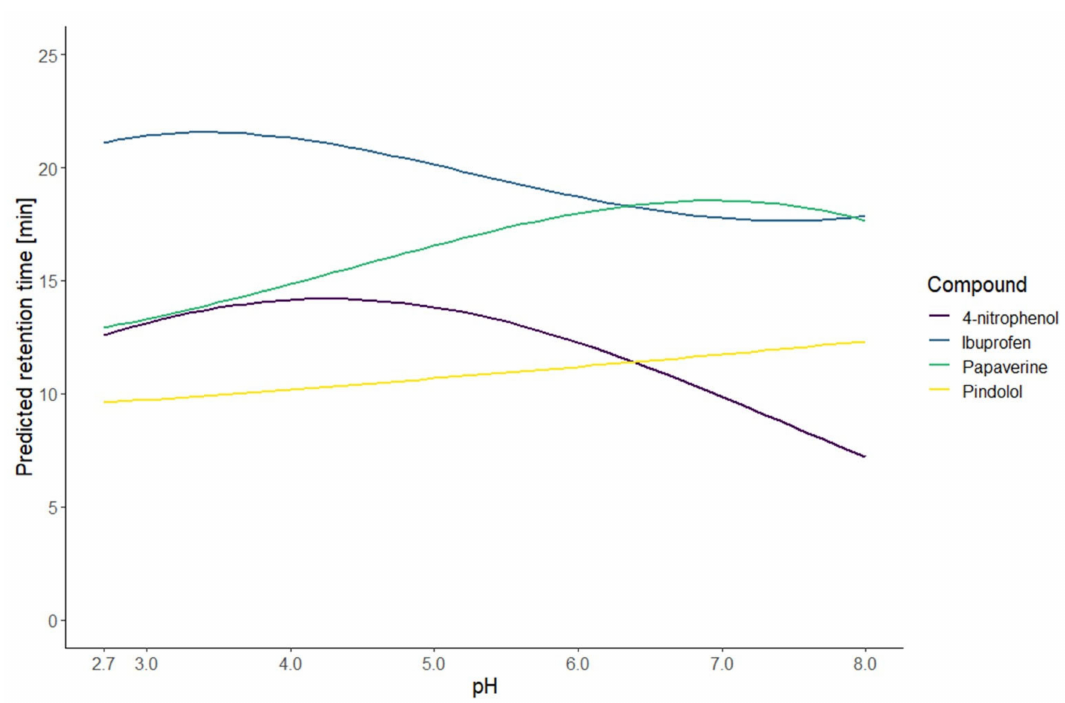
Figure 1. Curves of predicted retention times for the first test set of compounds for all the pH between 2.7 and 8.0 and a gradient time of 20 min.